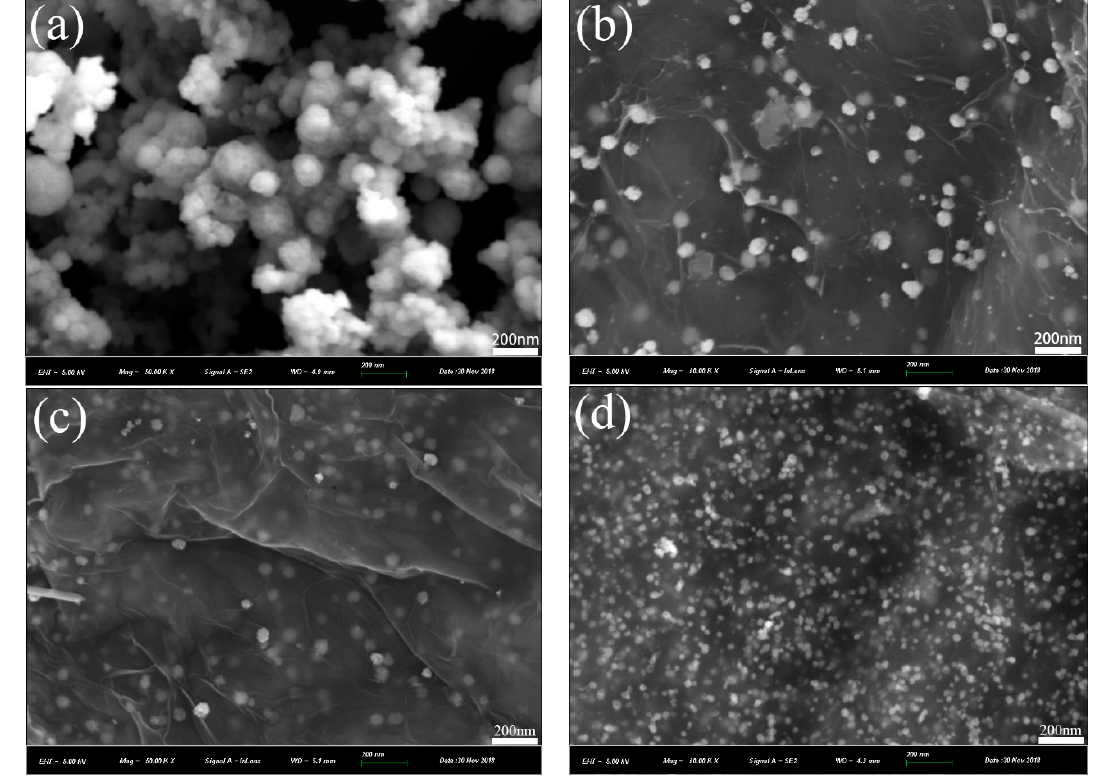
Figure 3. SEM images of CdSe ( a ), CdSe/RGO-1:0.5 ( b ), CdSe/RGO-1:1 ( c ), CdSe/RGO-1:1.5 ( d ).